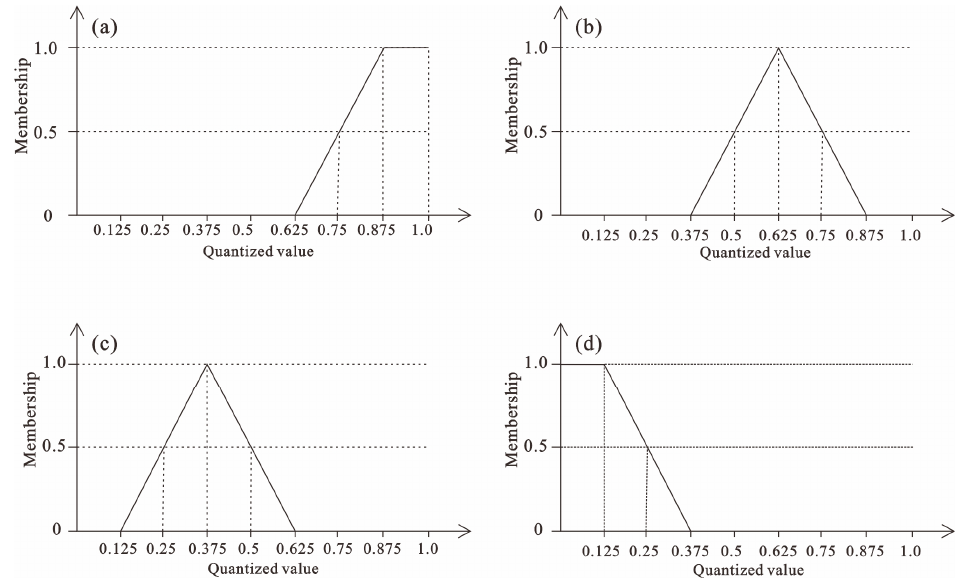
Figure 5. Membership functions at all levels. ( a ) Grade I membership function; ( b ) Grade II membership function; ( c ) Grade III membership function; ( d ) Grade IV membership function. Table 4. Results of CO 2 geological storage suitability